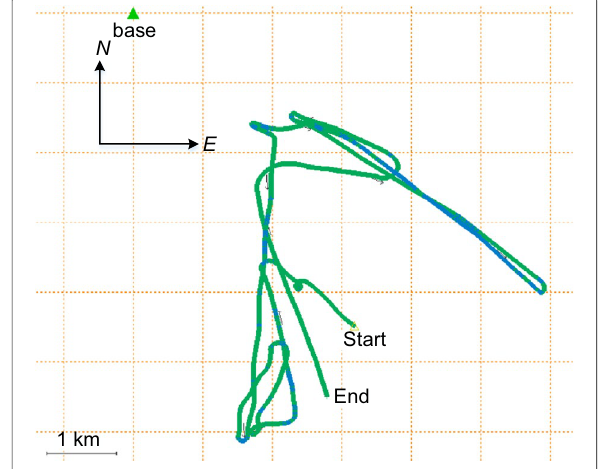
Fig. 10 Ship-borne reference trajectory